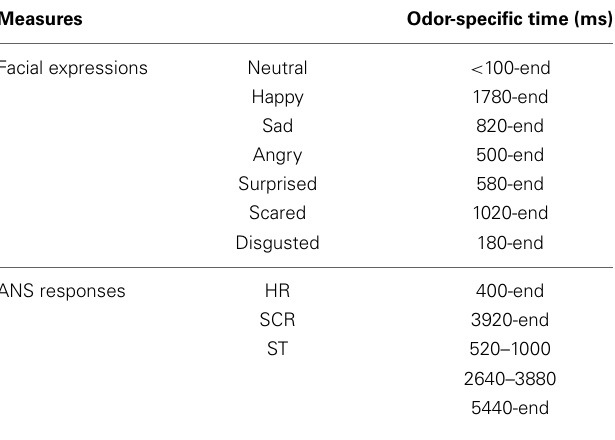
Table 3 | Intervals in ms following odor presentation at which responses become